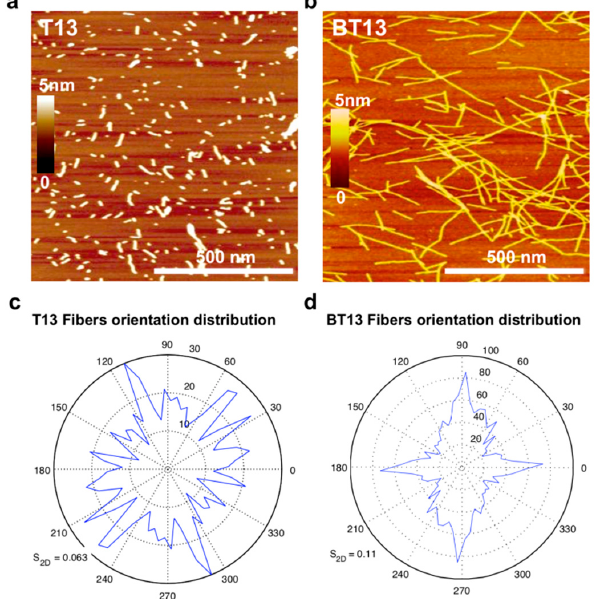
Figure 2. Morphological organization of T13 and BT13 peptide nanostructures. Atomic force microscopy images of ( a ) T13 and ( b ) BT13 peptides. Orientation distribution of ( c ) T13 and ( d ) BT13 peptides showing that the N-terminal biotin tag triggers a disorder-to-order transition in the BT13 assemblies. Scale bar, 500 nm.